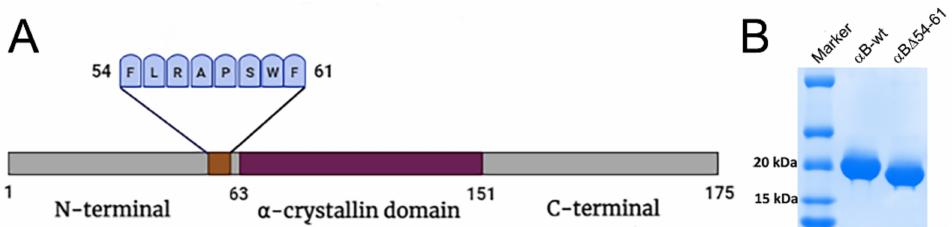
Figure 1. ( A ) Schematic representation of α B-crystallin showing central α -crystallin domain flanked by N-terminal domain and C-terminal domain and deleted 54–61 sequence. ( B ). SDS-PAGE profile of overexpressed and purified α B-wt and α B ∆